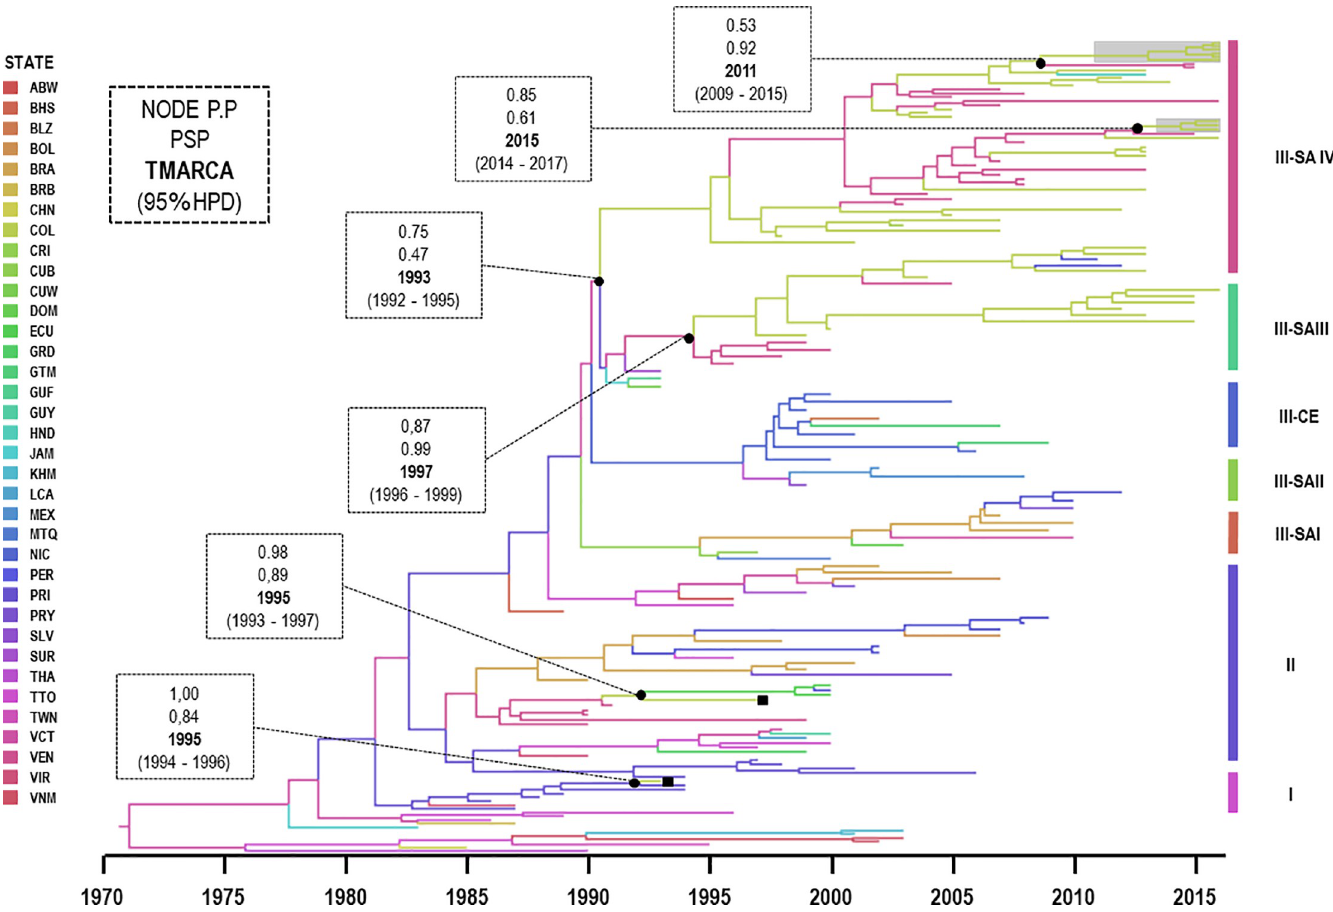
Fig 5. Maximum clade credibility tree of DENV-2 corresponding to Asian–American genotype. Branches are coloured according to the most probable location of their parental node and legend shown on the left side. All horizontal branch lengths are drawn to a scale of years. Three clades (I–III) and subclade of the clade III are identified on the right side and the gray frame represents our sequences isolated from Villa del Rosario, Norte de Santander. ■ : virus strains isolated in 1993 (AY484644) and 1997 (DQ364497) available in Genbank. PSP: posterior state probability, PP: posterior probability, TMRCA: the mean estimated time to the most recent common ancestor and 95% HPD: 95% highest posterior density interval. ABW: Aruba, BHS: Bahamas, BLZ: Belize, BOL: Bolivia, BRB: Barbados, CRI: Costa Rica, CUB: Cuba, CUW: Curacao, DOM: Dominica, ECU: Ecuador, GRD: Grenada, GTM: Guatemala, GUY: Guyana, COL: Colombia, GUF: French Guiana, LCA: Santa Lucia, NIC: Nicaragua, MTQ: Martinique, MEX: Mexico, PRY: Paraguay, PRI: Puerto Rico, JAM: Jamaica, PER: Peru, BRA: Brazil, TTO: Trinidad and Tobago, HND: Honduras, SLV: Salvador, SUR: Surinam, VCT: Saint Vincent and the Grenadines,VIR: United States Virgin Islands, VEN: Venezuela, TWN:Taiwan, KHM:Cambodia, VNM: